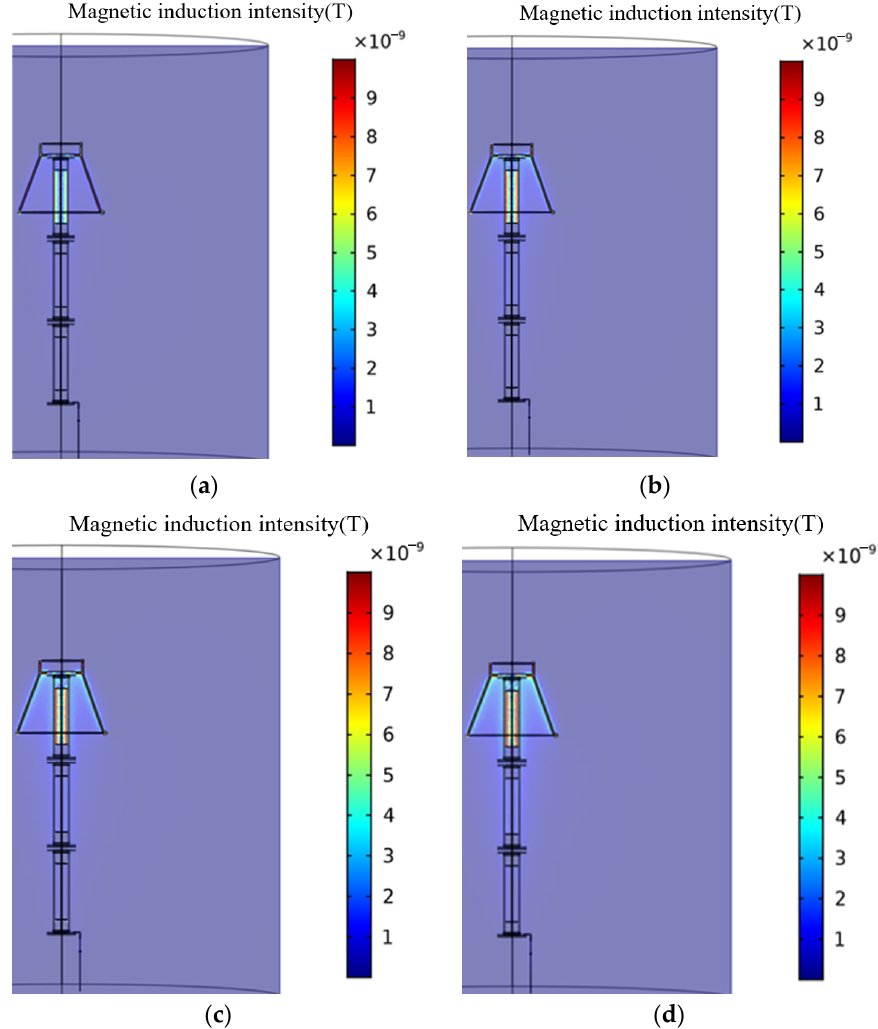
Figure 10. Magnetic field distribution of arrester under different voltages. ( a ) 289 kV; ( b ) 444 kV; ( c ) 577 kV; and ( d ) 666 kV.